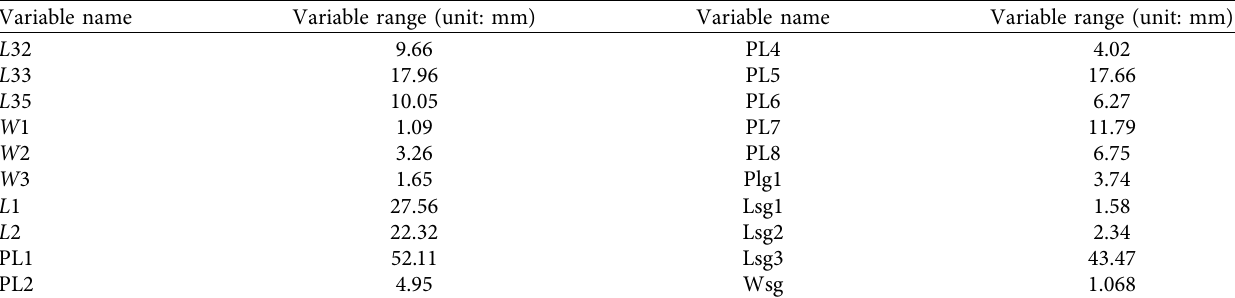
Figure 5: The DGP network model structure. Table 2: Optimized parameters of the multiband microstrip